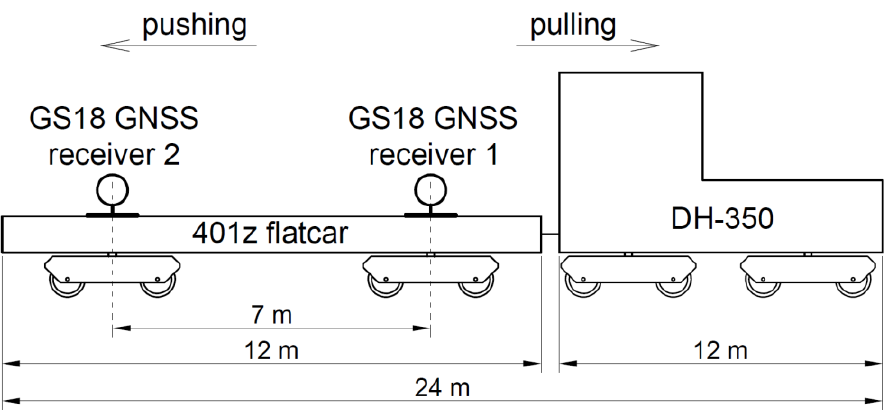
Figure 6. Configuration of the devices of measuring set number 3 and the directions of running.